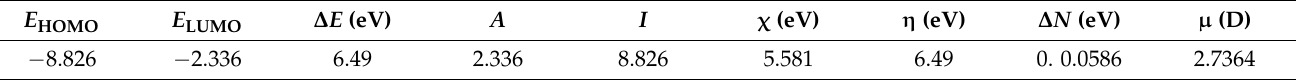
Table 5. Calculated quantum parameters of the studied inhibitor.